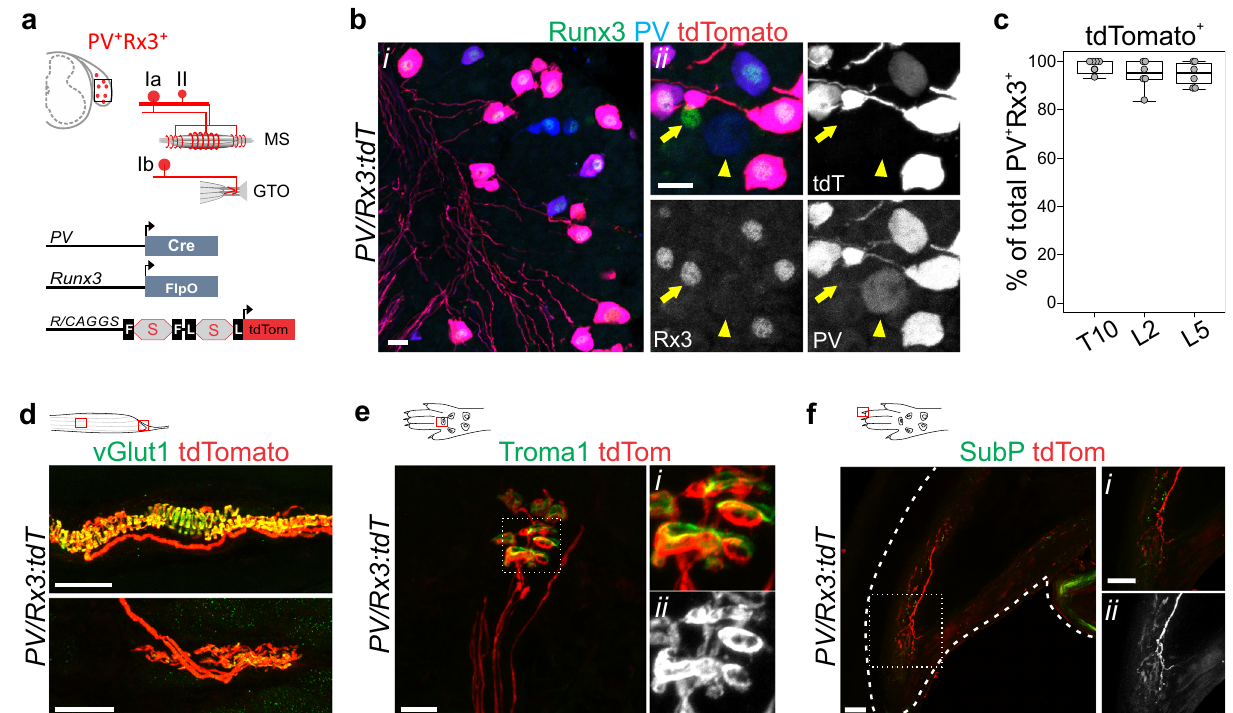
Fig. 1 An intersectional genetic labeling strategy for proprioceptive muscle afferents. a Schematic rendering of the groups Ia, II and Ib proprioceptor subtypes labeled in mice carrying a PV:Cre , Rx3:FlpO , and the double stop Ai65:tdTomato allele ( PVRx3:tdT ). In sensory neurons that co-express PV and Rx3, the dual activity of Cre and FlpO recombinases will allow expression of the tdTomato reporter. b Expression of Runx3, PV, and tdTomato in DRG at p2 indicates ef fi cient induction of the tdTomato reporter in PV + Rx3 + sensory neurons, but not in PV + Rx3 off (arrowhead in ii) or PV off Rx3 + (arrow in ii) neurons (i and ii are independent images). c Ef fi ciency of tdTomato reporter induction in T10, L2, and L5 DRG in p2 PVRx3:tdT mice. Mean percentage±S.E.M. of tdT + PV + Rx3 + neurons (of all PV + Rx3 + ) per ganglia for T10: 98.0±1.3%, for L2: 94.4±2.5%, for L5: 94.8±1.9%; n = 6 DRG per segmental level. Number of sections per T10 DRG: 7, 6, 6, 7, 7, 8; Number of sections per L2 DRG: 7, 3, 6, 5, 8, 7; Number of sections per L5 DRG: 9, 8, 10, 6, 7, 10. d tdTomato expression in vGlut1 + muscle spindle (MS) and Golgi tendon organ (GTO) afferent terminals in p10 EDL muscle of PVRx3:tdT animals. Diagram depicts muscle with red boxes showing areas in images below. Expression of tdTomato in Merkel cell afferents present in hind paw glabrous skin ( e ) and in SubstanceP(SubP) off sensory neurons that appear cells are indicated by expression of Troma1. i, ii show higher magni fi cations of boxed areas in e , f ; ii shows tdTomato expression. Similar data obtained from at least three ( b , d , e ) biological replicates. In boxplot ( c ), boxes indicate medians and 25th/75th percentiles, and whiskers extend to the furthest point <1.5 standard deviations from the mean. Scale 20 ( b ) or 50 ( d – f ) μ